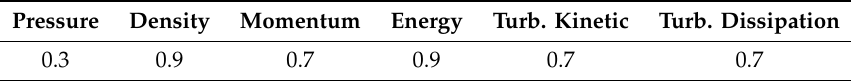
Table 5. Values of under-relaxation